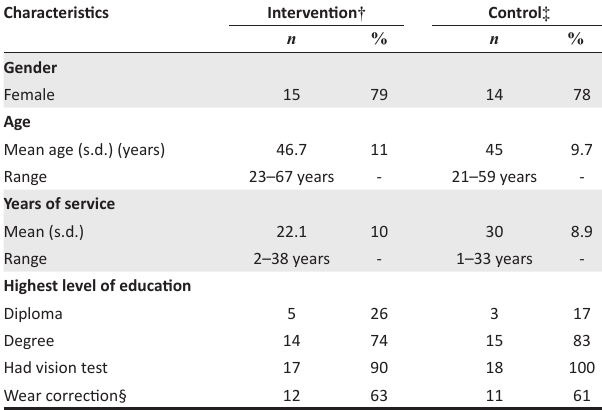
TABLE 1: Characteristics and ocular history of Grade 5 educators in Chatsworth primary schools in 2013.